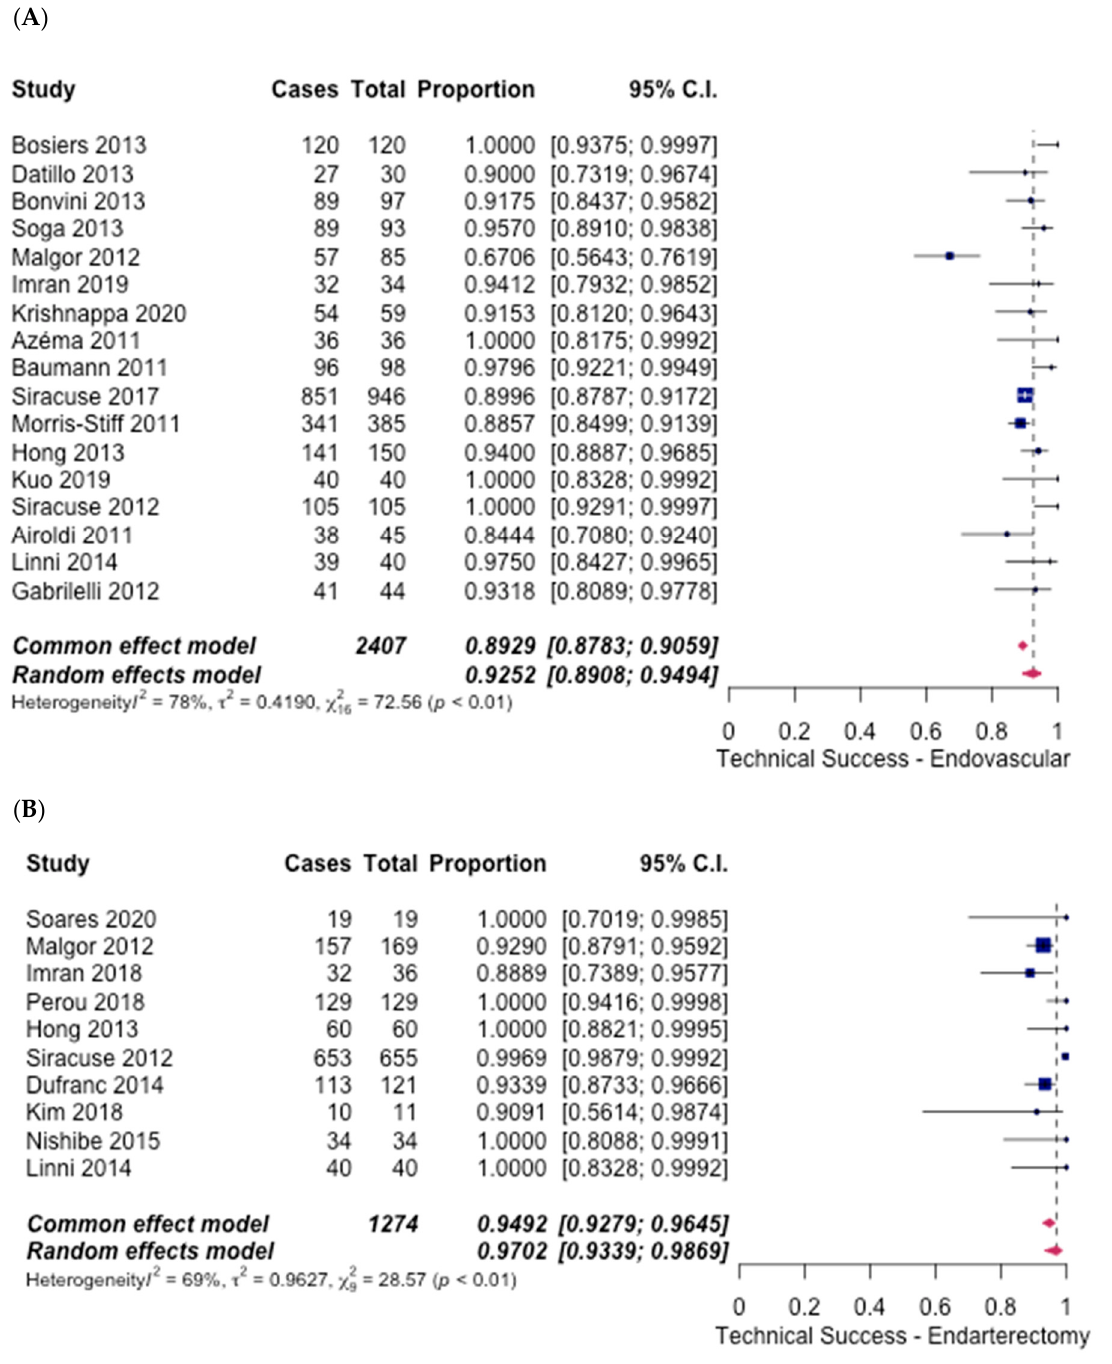
Figure 2. Forest plot for technical success. ( A ) Endovascular intervention [6–22]. ( B ) Endarterec-